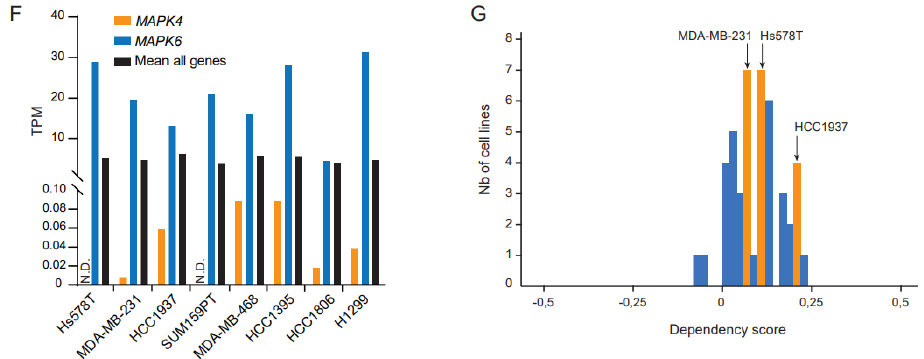
Figure 1. Expression of ERK4 mRNA and protein in TNBC cell lines. ( A ) Expression of MAPK4 and MAPK6 mRNA was measured by real-time qPCR in the human TNBC cell lines Hs578T, MDA-MB231 and HCC1937, the breast epithelial cell line MCF10A, and control H1299, HeLa and HEK 293T cells. Results are expressed as Ct. Data are means ± SD ( n = 3). ( B ) Expression of MAPK4 and MAPK6 mRNA in Hs578T and MDA-MB-231 measured by RNA-seq. Results are expressed as TPM and correspond to the mean ± SD of triplicate samples. ( C) Expression of ERK4 and ERK3 proteins were analyzed by Western blotting using the indicated antibodies. ERK4 was depleted from HeLa cells by siRNA. ( D ) Hs578T were transfected with HA-ERK4 and analyzed by Western blotting with the indicated antibodies. ( E ) Expression of the ERK3 protein was analyzed by Western blotting. ( F ) Expression of MAPK4 and MAPK6 mRNA in human TNBC cell lines and H1299 NSCLC cell line extracted from the CCLE database. ( G ) MAPK4 gene dependency of breast cancer cell lines. The gene dependency score of MAPK4 was estimated from a CRISPR/Cas9 loss-of-function screen of human cancer cell lines and extracted from the DepMap portal (https://depmap.org/portal/gene/MAPK4?tab=dependency; accessed on 19 October 2022). A cell line is considered dependent if the dependency score is < − 0.5. A score of 0 indicates a gene that is not essential. The median scores of essential genes is − 1.0.